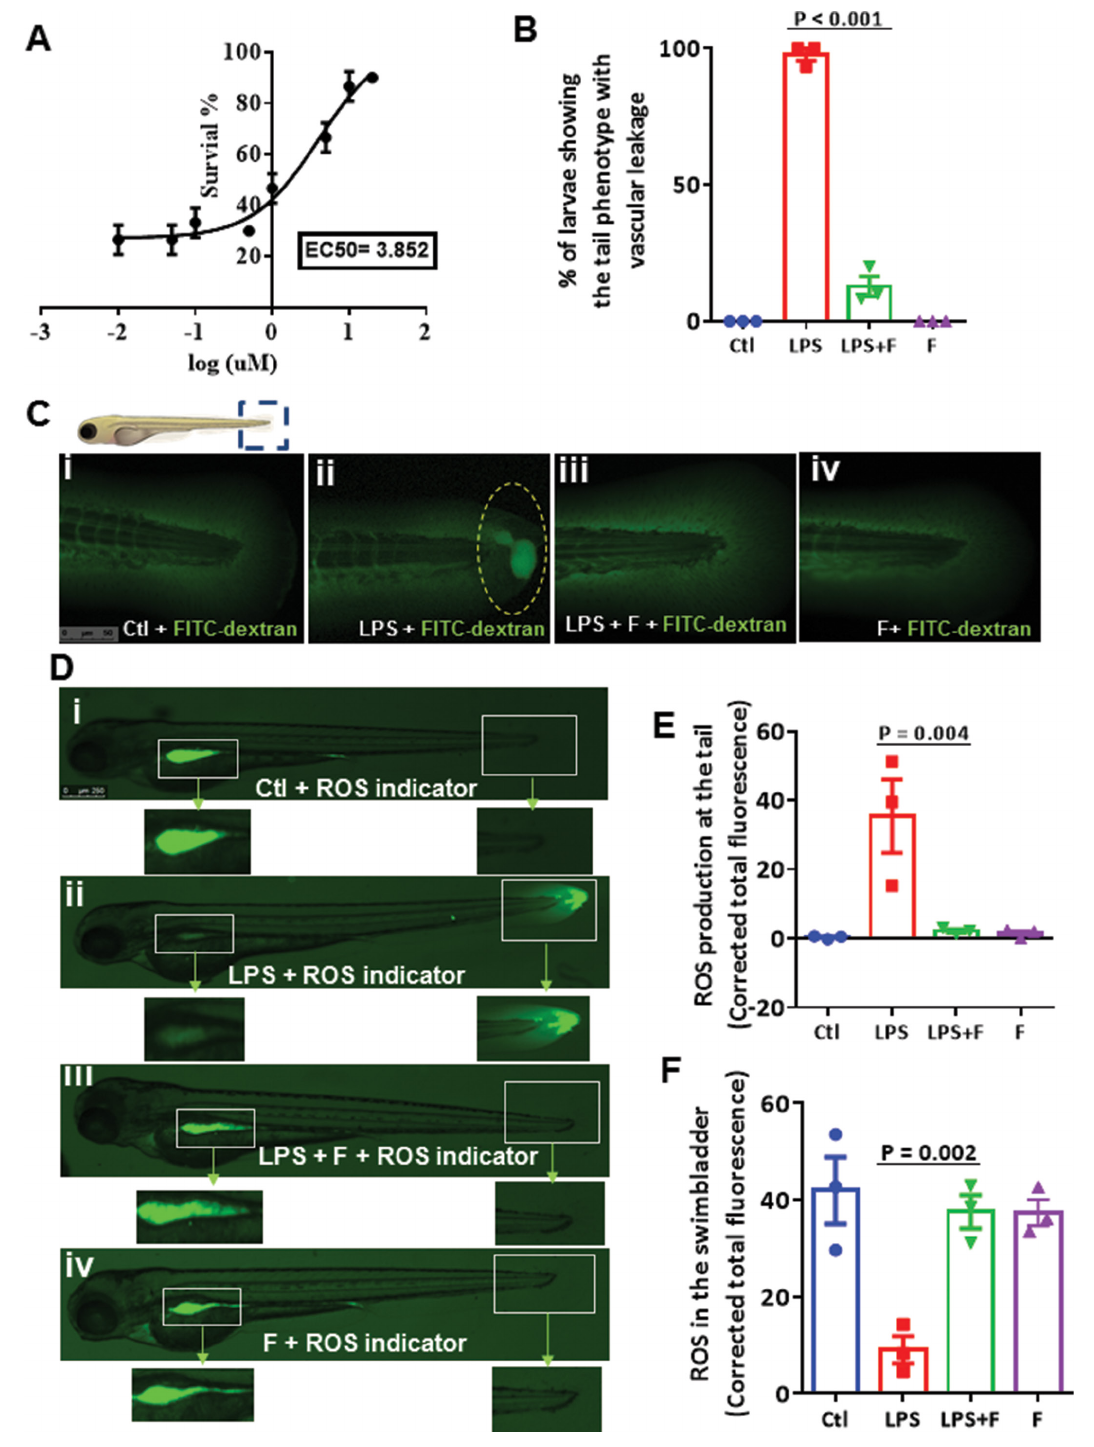
Figure 8. (A)Fasudil reverses LPS-induced vascular leakage and ROS production. Fasudil has an EC50 of 3.852 μ M. (B, C) Fasudil mitigates LPS-induced vascular leakage and the resulting leakage of FITC-dextran and its accumulation at the tail fin (an average of 3 trials of 10 larvae/treatment). (D, E) Fasudil also rescued LPS-induced ROS production at the tail fin (an average of 3 trials of 3 larvae/treatment) and (F) LPS-induced reduction of ROS in the swim bladder (an average of 3 trials of 3